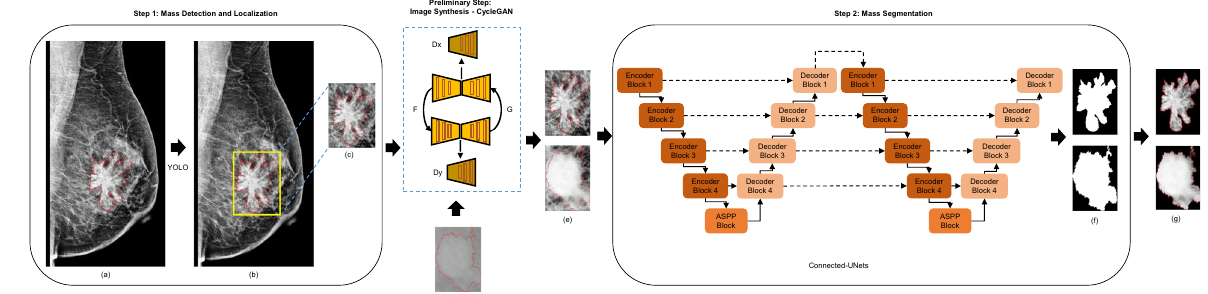
Fig. 9 The proposed integrated framework. a Original mammogram with ground truth of mass (red). b Detected ROI of mass (yellow) superimposed on the original mammogram. c Detected ROI (i.e., input mass) obtained with ground truth (red) (Domain X). d Detected ROI obtained from a different mammography dataset (Domain Y). e Original ROI (Domain X) and Synthetic ROI (transferred from Domain Y to Domain X). f Output segmented binary mask of input mass. g Segmented output mass where tissue is